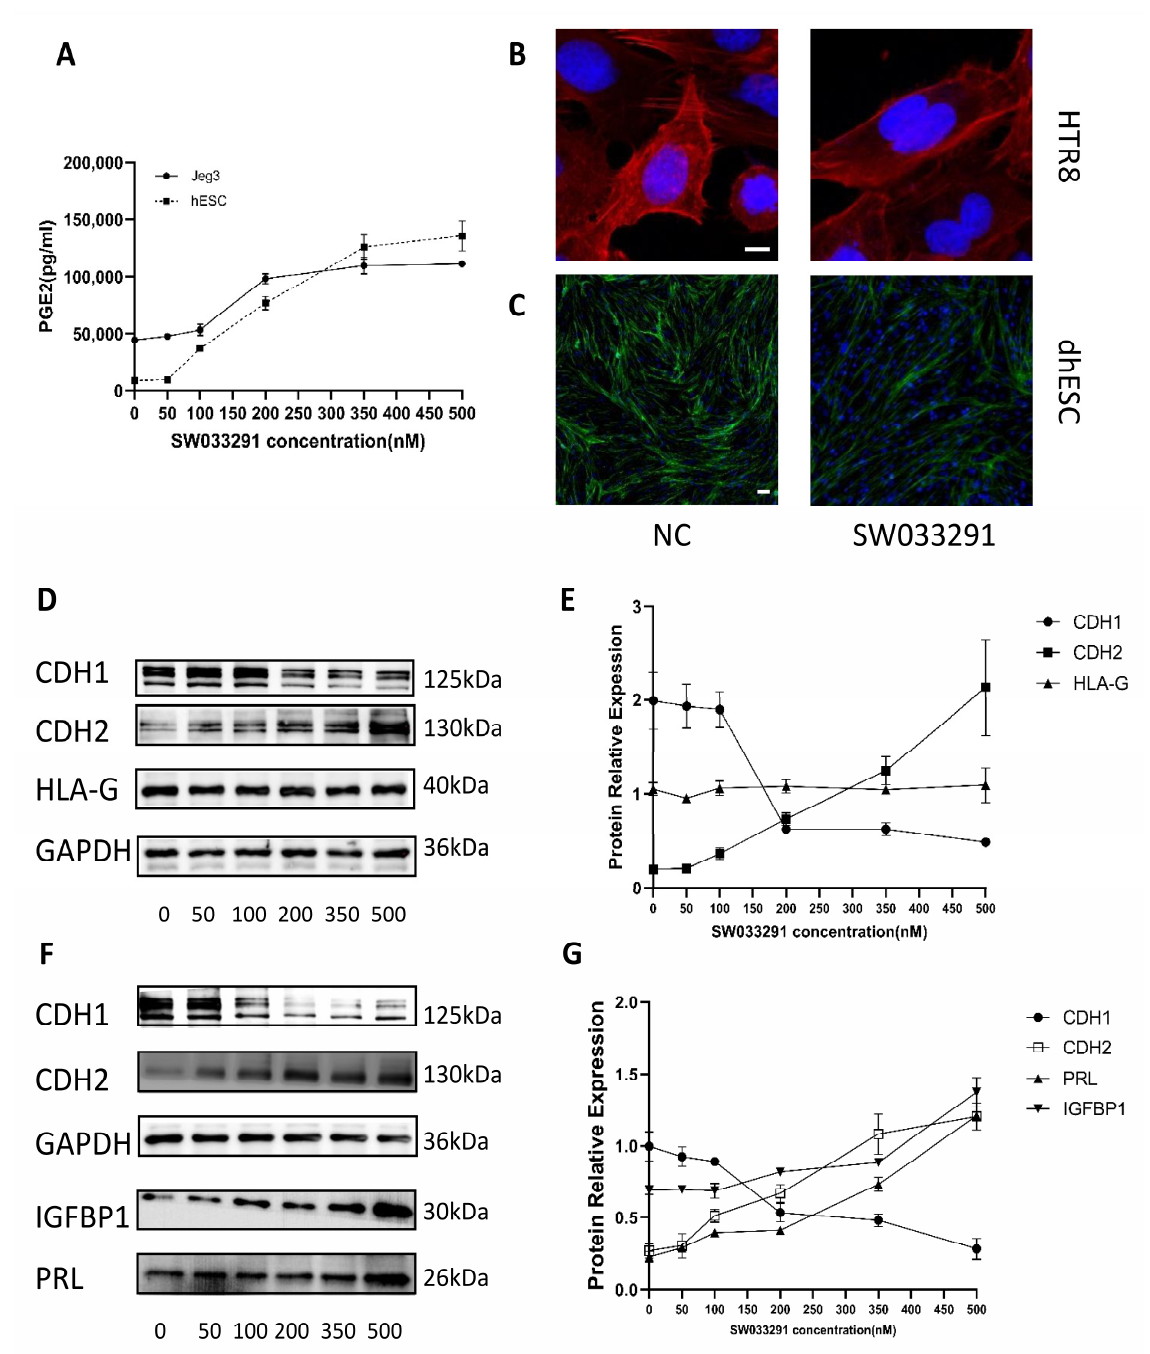
Figure 5. Function of 15-PGDH. ( A ) PGE2 levels in cell lysates were quantified by ELISA. The results are representative of at least three independent experiments. ( B , C ) F-actin staining revealed cytoskeletal changes in dhESCs and HTR8 cells in the NC (normal control) group and SW033291 group. ( D , E ) Western blot assays show the relative levels of EMT markers and HLA-G in Jeg3. ( F , G ) Western blot assays show the relative levels of EMT markers and decidualization markers in hESC. Each experiment was independently performed three times. CTB: cytotrophoblast; EVT: extravillous trophoblasts; EMT: epithelial–mesenchymal transition; DSC: decidual stromal cell. The experiment was repeated 3 times independently. Band intensities were quantified and normalized to the GAPDH values. Values are the mean ± SD.